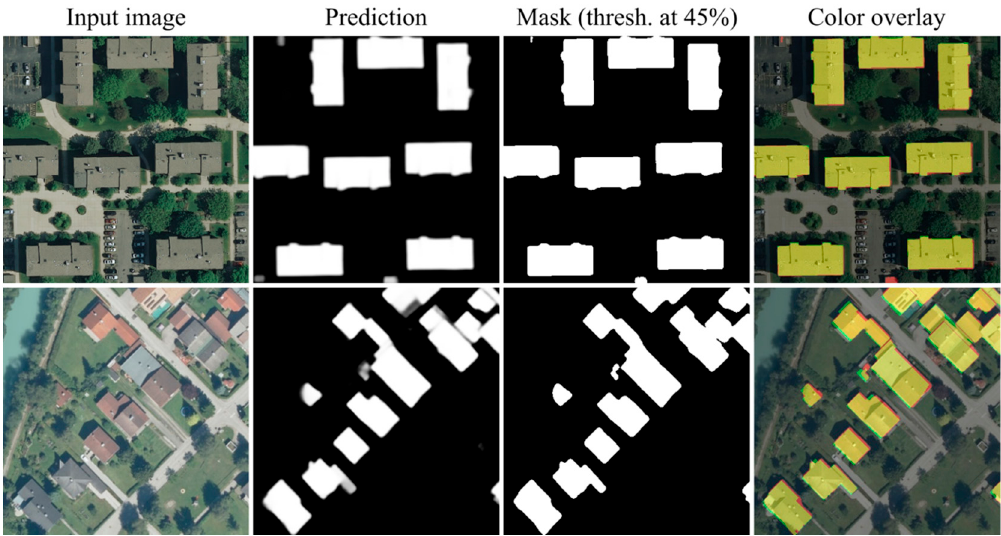
Figure 11. Examples of correctly segmented buildings. The color overlay shows the obtained mask in red and the ground truth in green, resulting in a yellow overlay where those two overlaps.